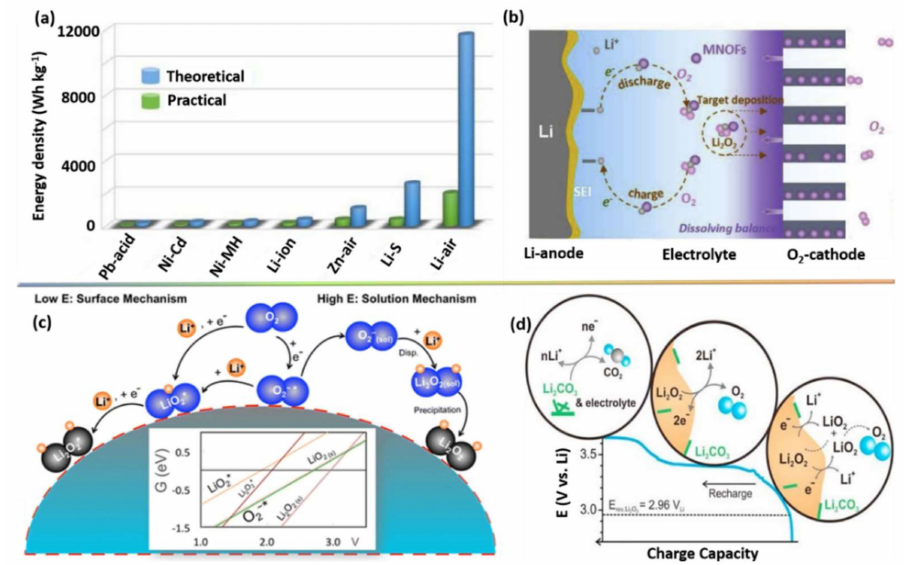
Figure 2. ( a ) Theoretical and practical energy density of various energy storage devices